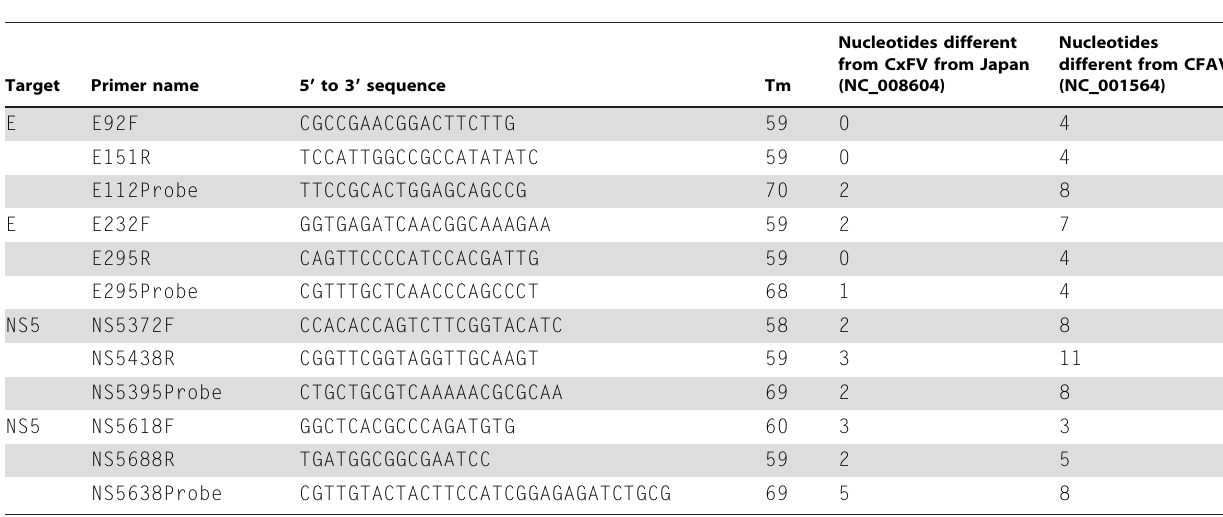
Table 1. qRT-PCR primers and probes used for detection and quantification of CxFV Izabal RNA.